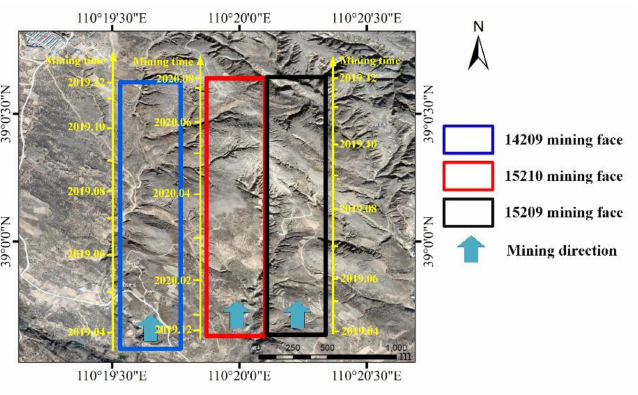
Figure 6. Mining time of three mining faces (the yellow axis represents the mining time).